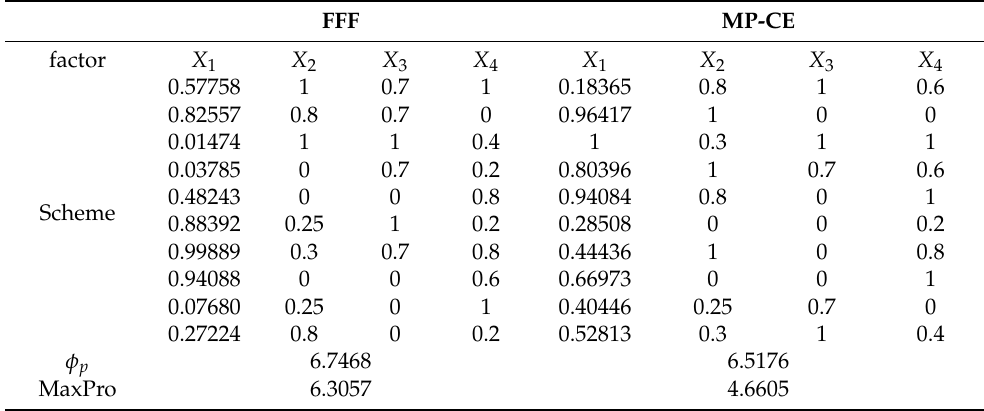
Table 3. Comparison of design results.